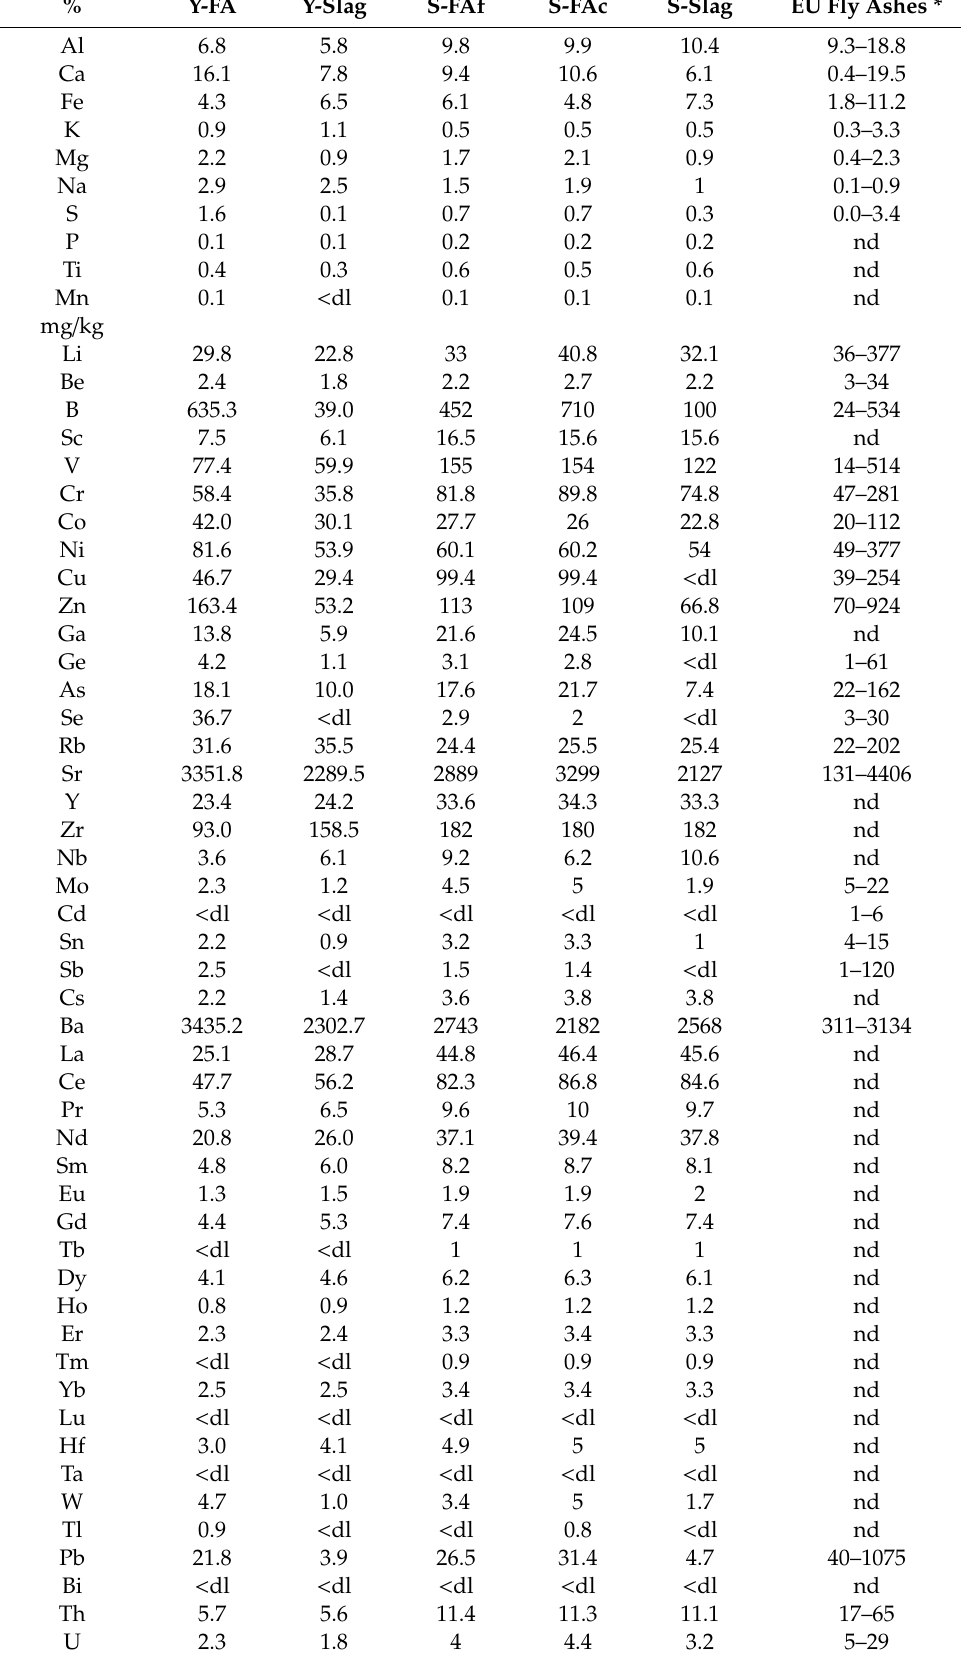
Table 4. Major and trace element concentrations of fly ash and slag samples for Shenhuo and Yihua power